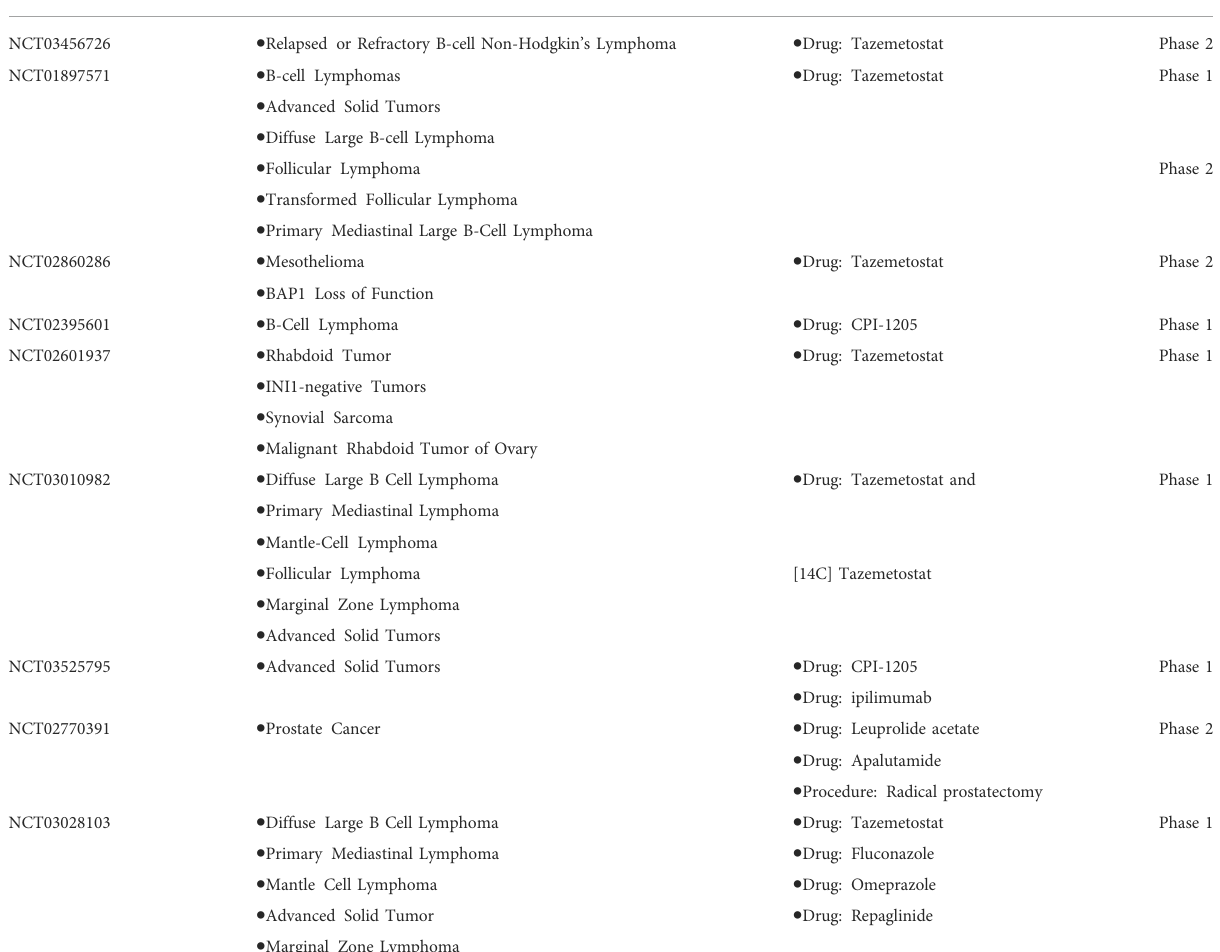
TABLE 2 Completed EZH2-targeted clinical trials in